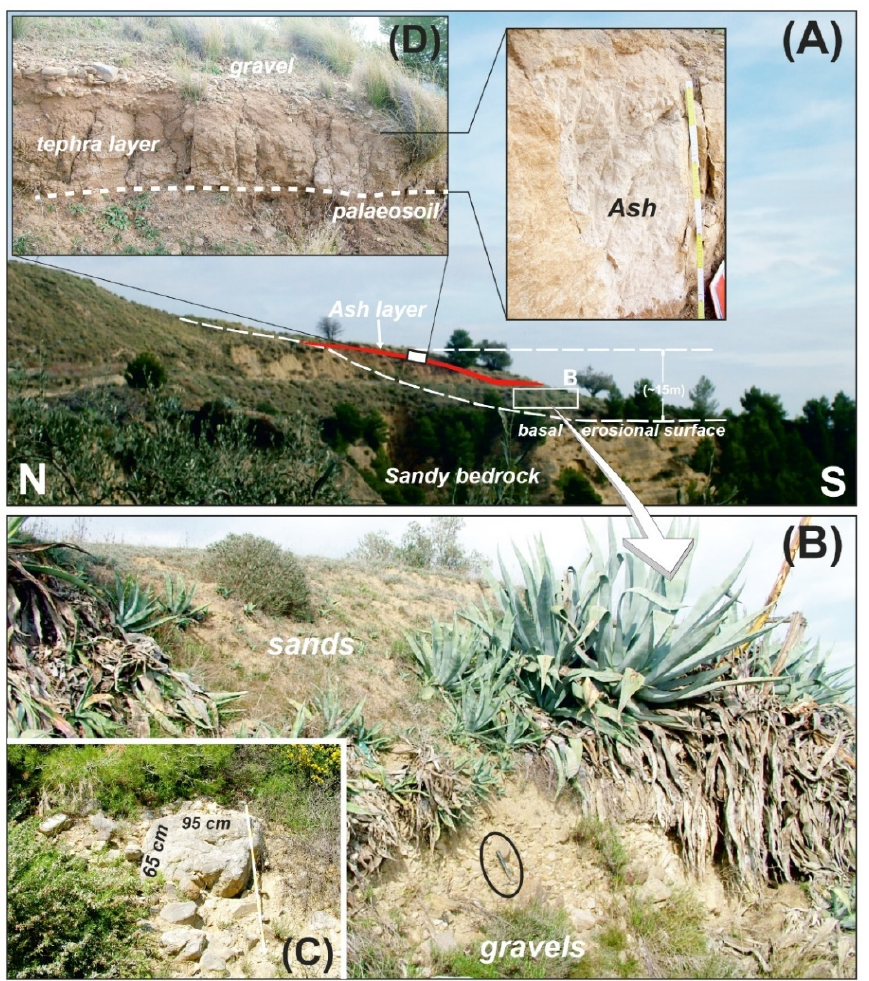
Figure 8. Panoramic view of the S. Francesco terraced unit ( A ). Fining upward sequence at the bottom of the FT 5a subunit ( B ). Coarse gravel embedded in the FT 5a deposit ( C ). The two small boxes in (A) show details of the tephra layer TU1 ( D ).